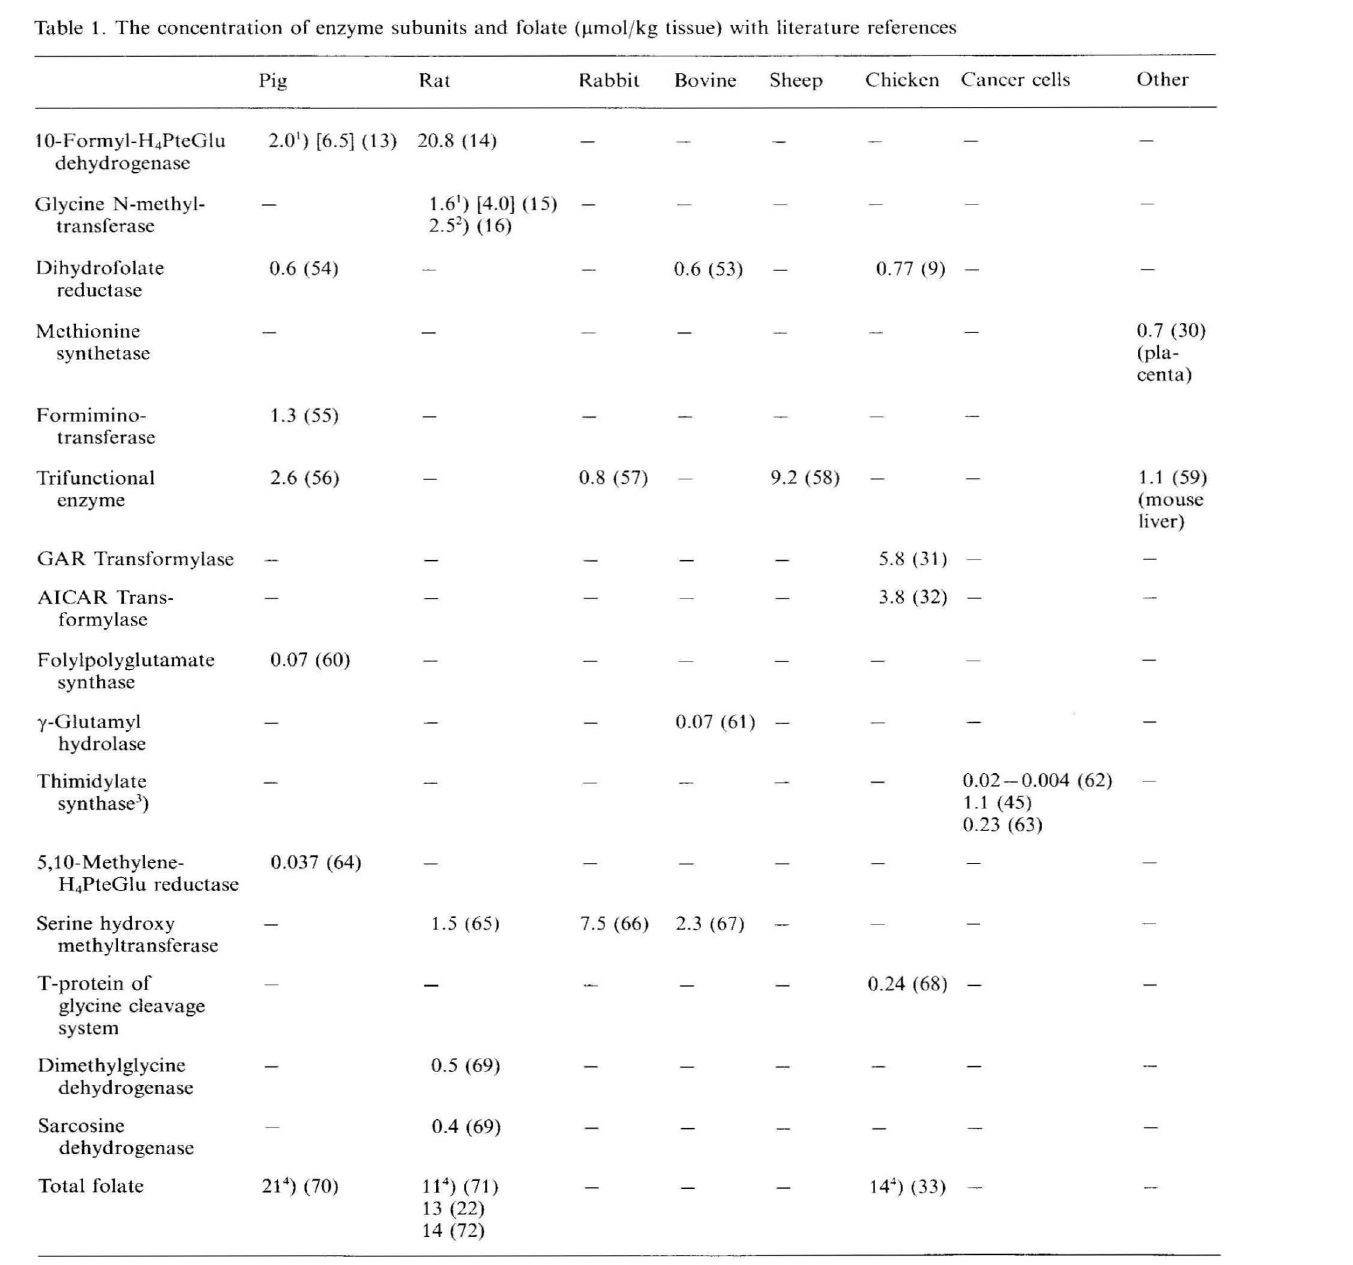
Table 1. The concentration of enzyme subunits and folate (~mol/kg tissue) with literature references